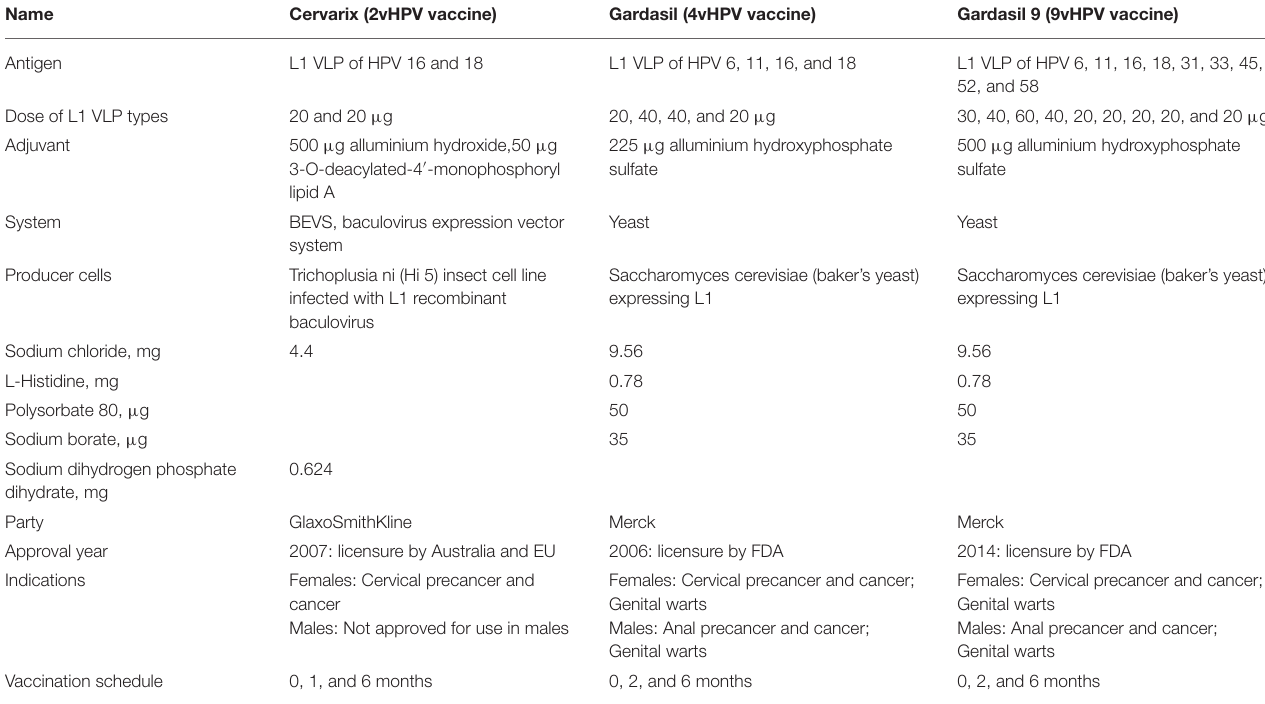
TABLE 1 | Characteristics of HPV vaccines.